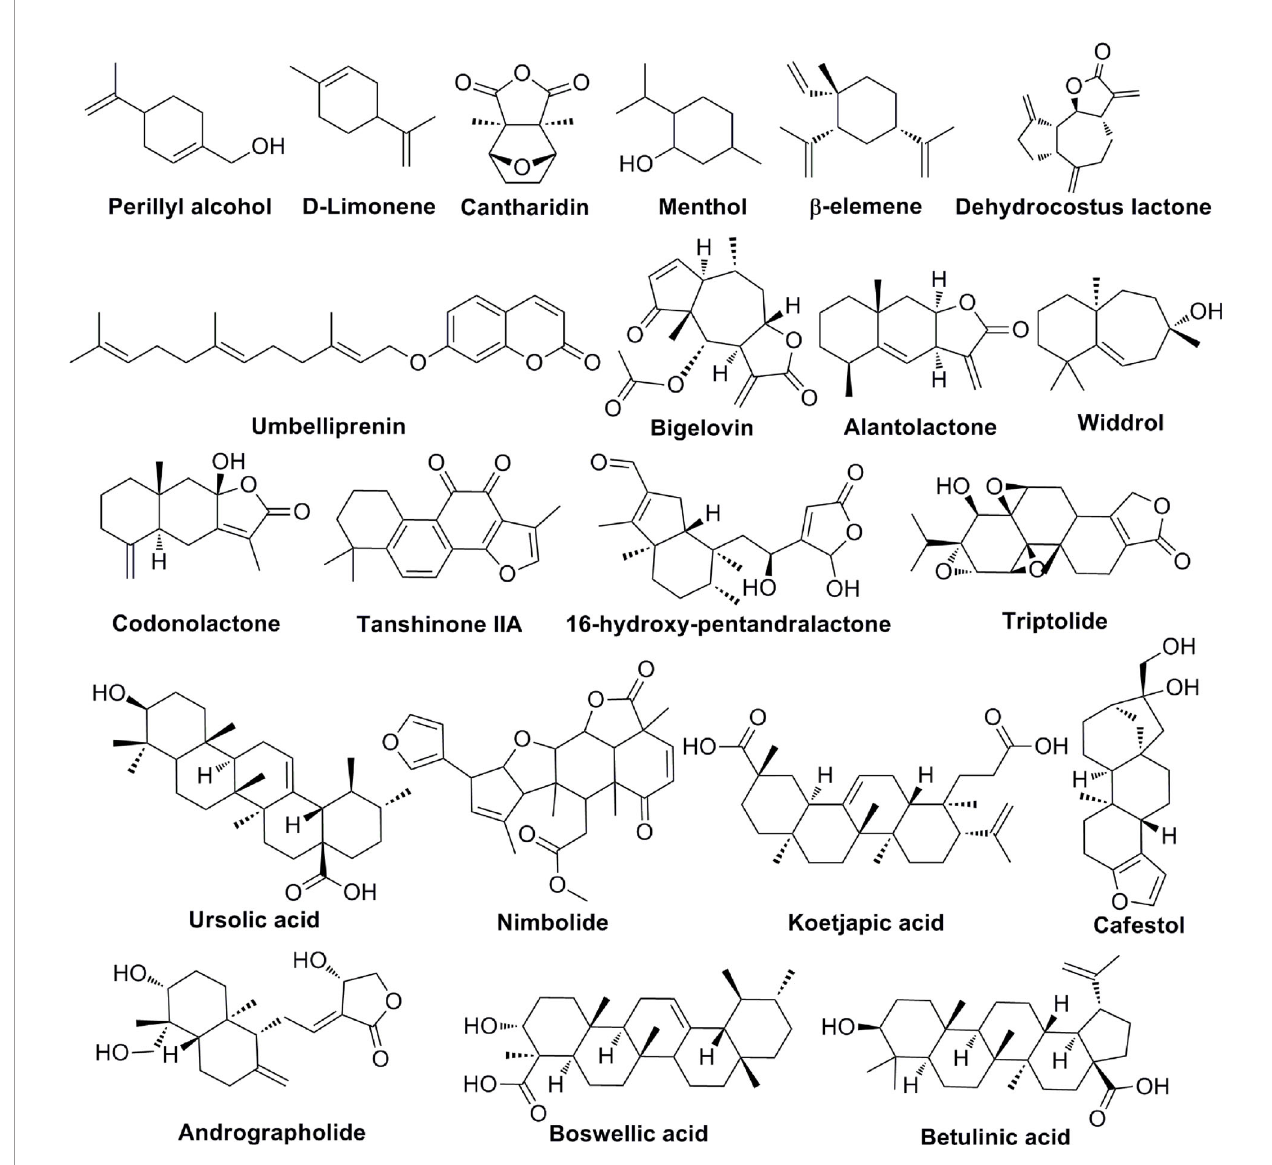
FIGURE 5 | The chemical structures of terpenoids involved in tumor